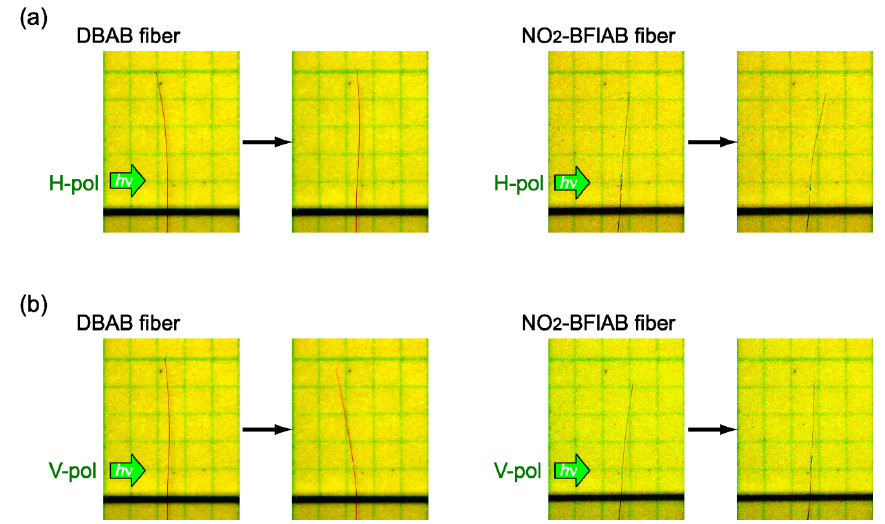
Figure 3. Photomechanical bending motions of DBAB and NO irradiation with ( a ) H-polarized laser beam ( b ) V-polarized one. Interval of grid lines: 1